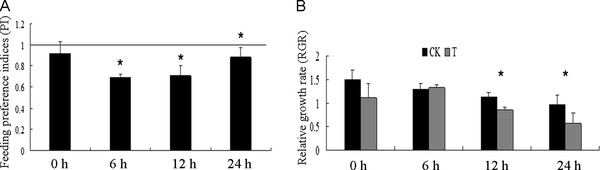
Identification of induced resistance. A, Feeding preference indices in dual-choice tests.B, Relative growth rate of cotton worms fed with control (CK) and treated (T) leaves. Error bars represent the standard deviation. * Significant (P < 0.05).